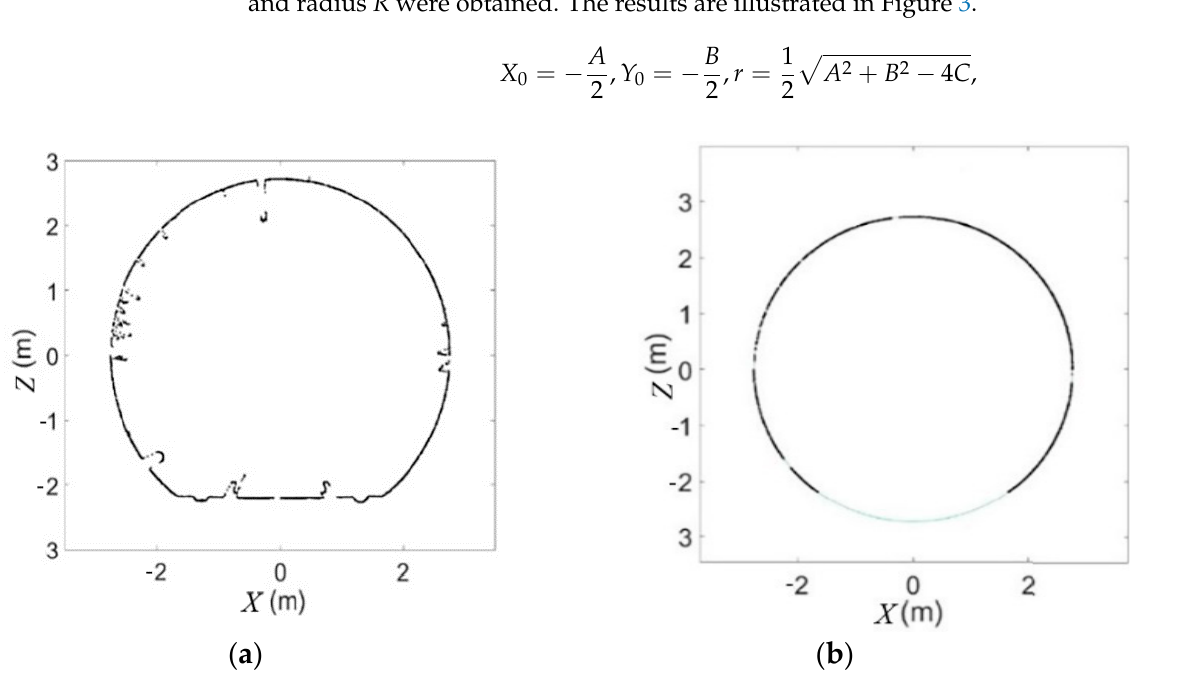
Figure 3. Before section fitting ( a ) and after section fitting ( b ).